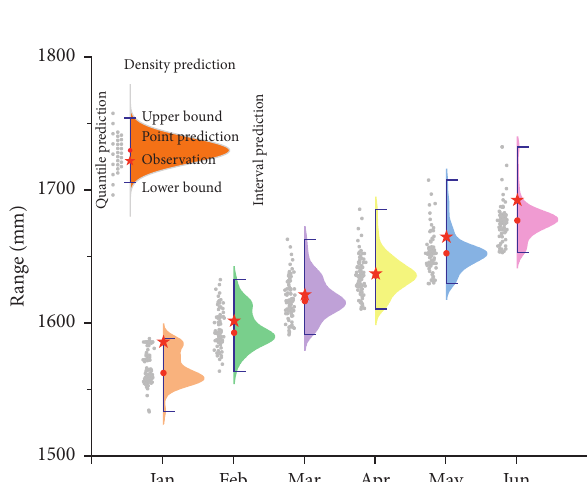
Figure 9: Probability density distribution of predictive displace- ment based on polynomial KSVMQR at ZG289 spanning the period of January 2015 to June